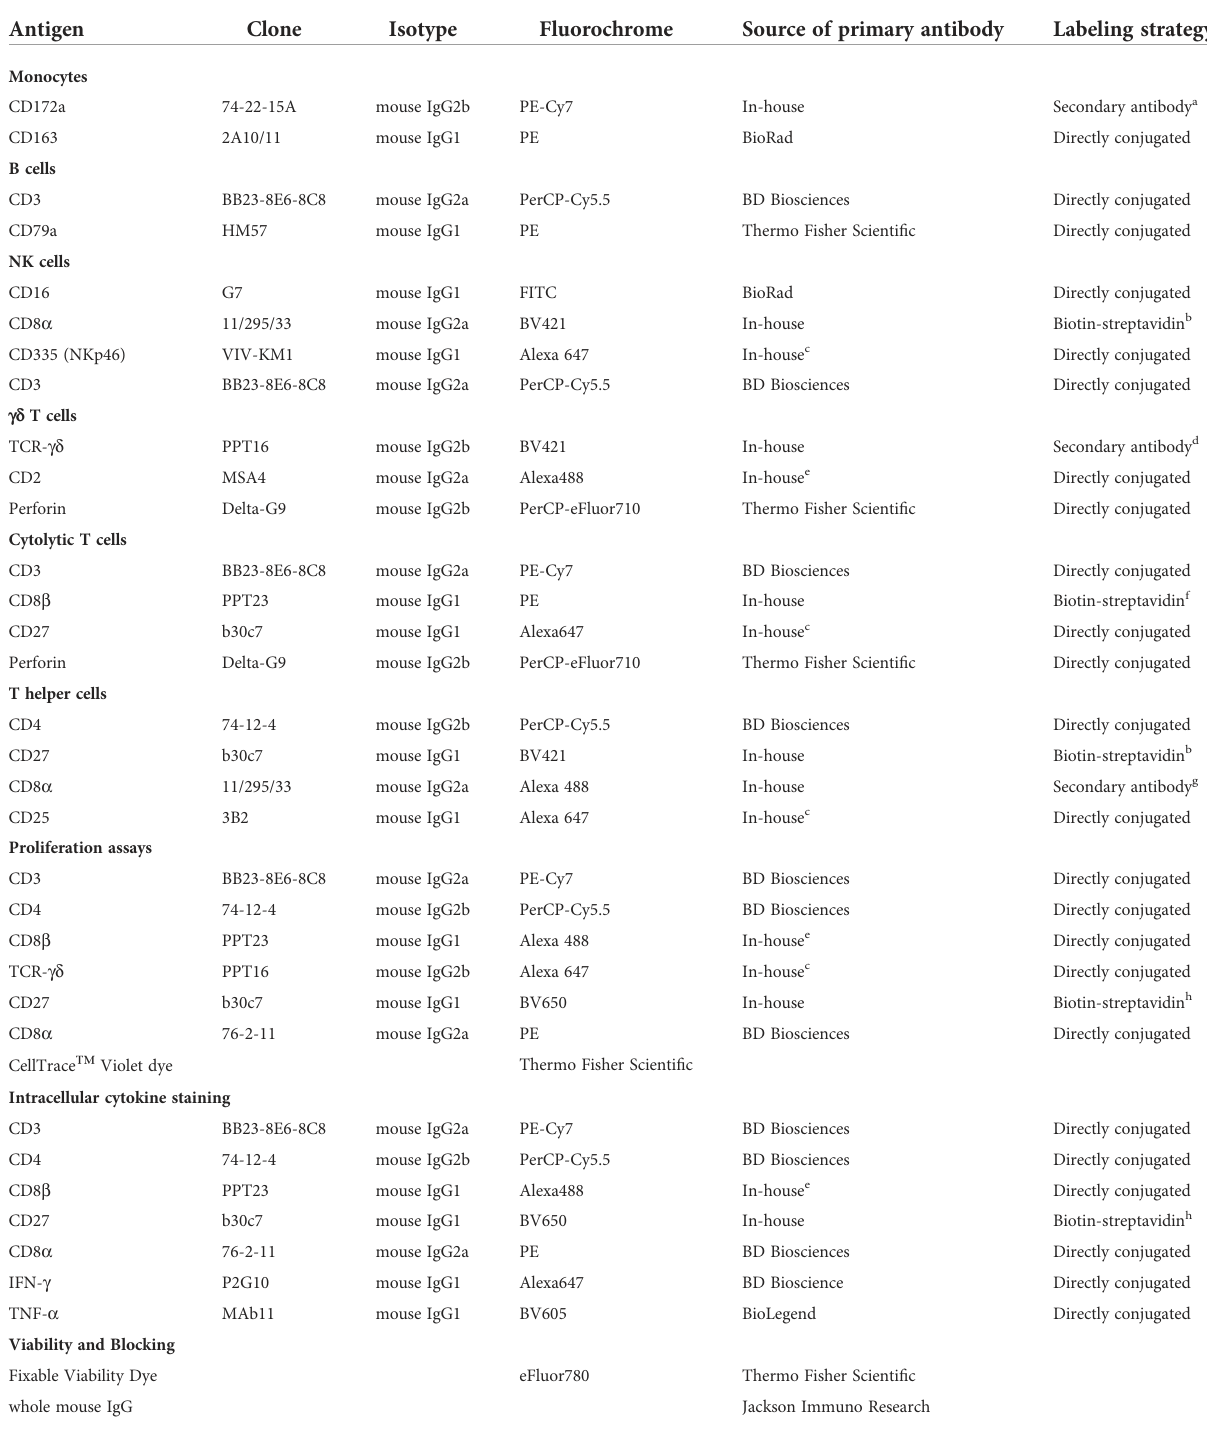
TABLE 1 Antibodies used for FCM